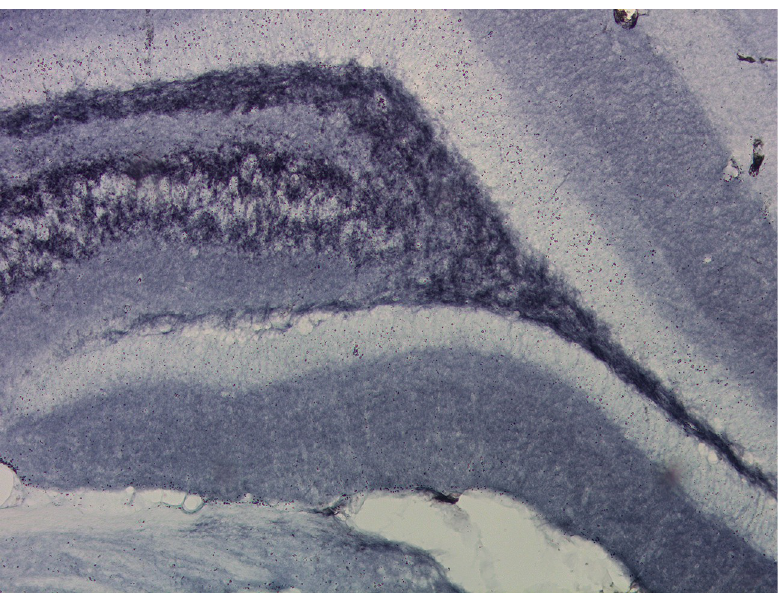
Fig 3. Immunohistochemical photograph. Representative picture of the synaptophysin stained dorsal hippocampus at 10 × magnification.